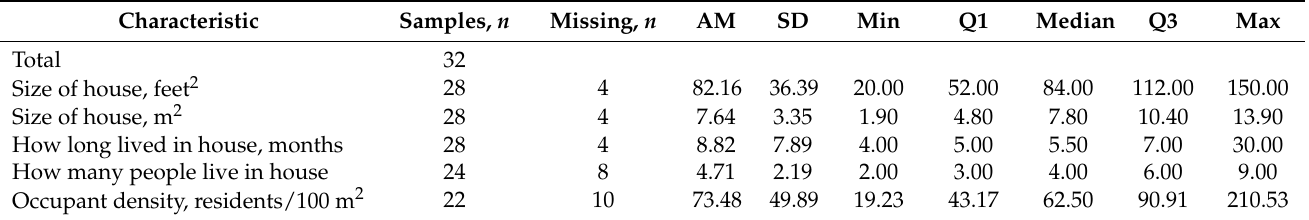
Table 1. Characteristics of air pollution samples collected inside and outside homes at brick kilns in Bhaktapur, Kathmandu Valley, Nepal, May